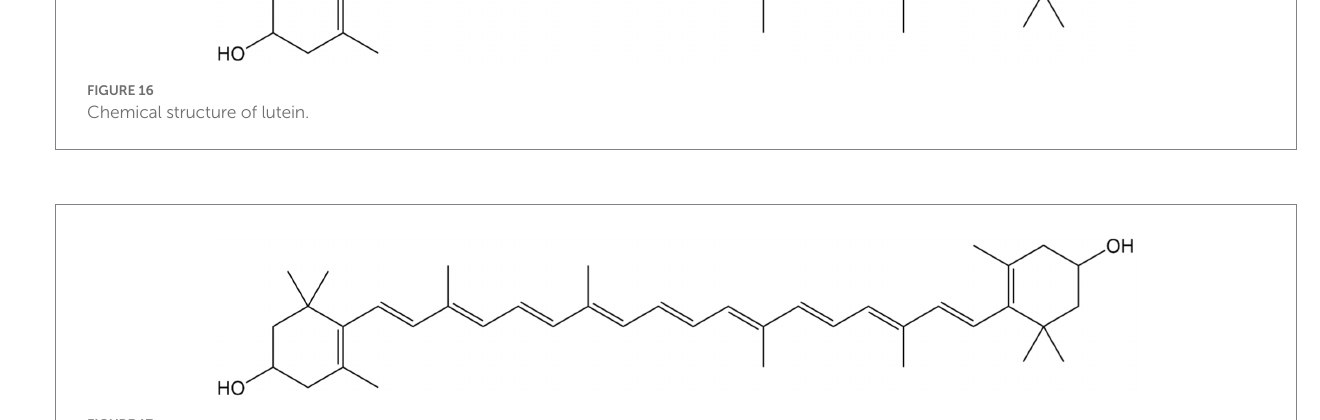
FIGURE 17 Chemical structure of